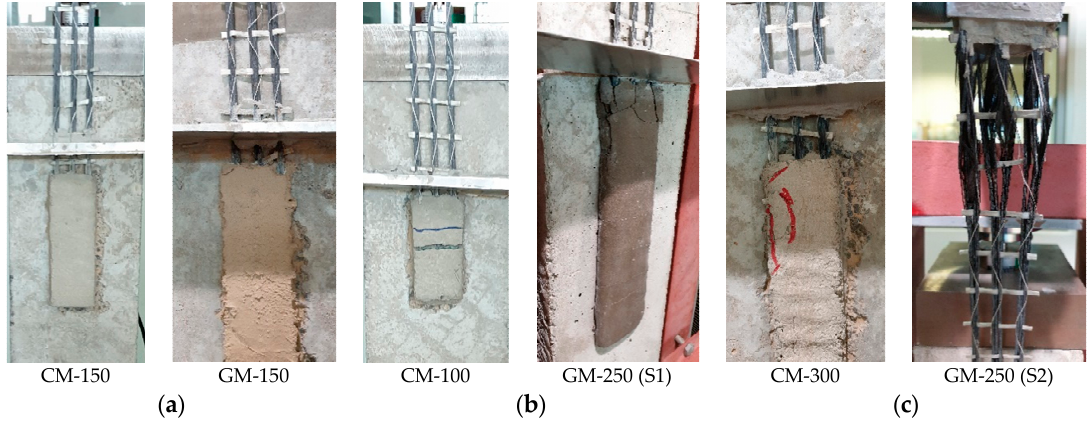
Figure 4. Typical modes of failure: ( a ) Mode I; ( b ) Mode II; ( c ) Mode III.